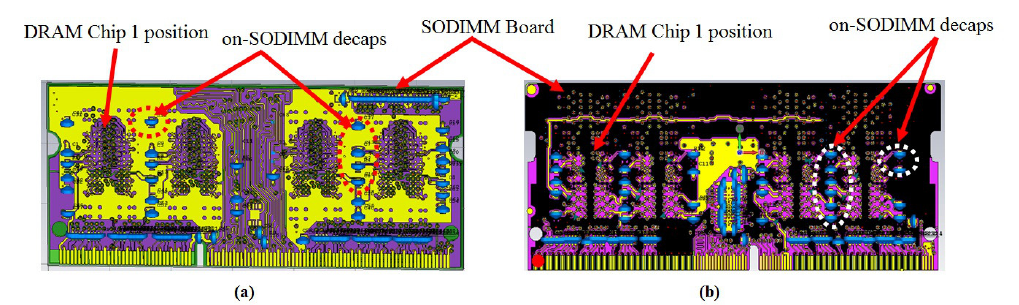
Figure 7. Imported design file models in CST MWS: ( a ) DDR3; and ( b )